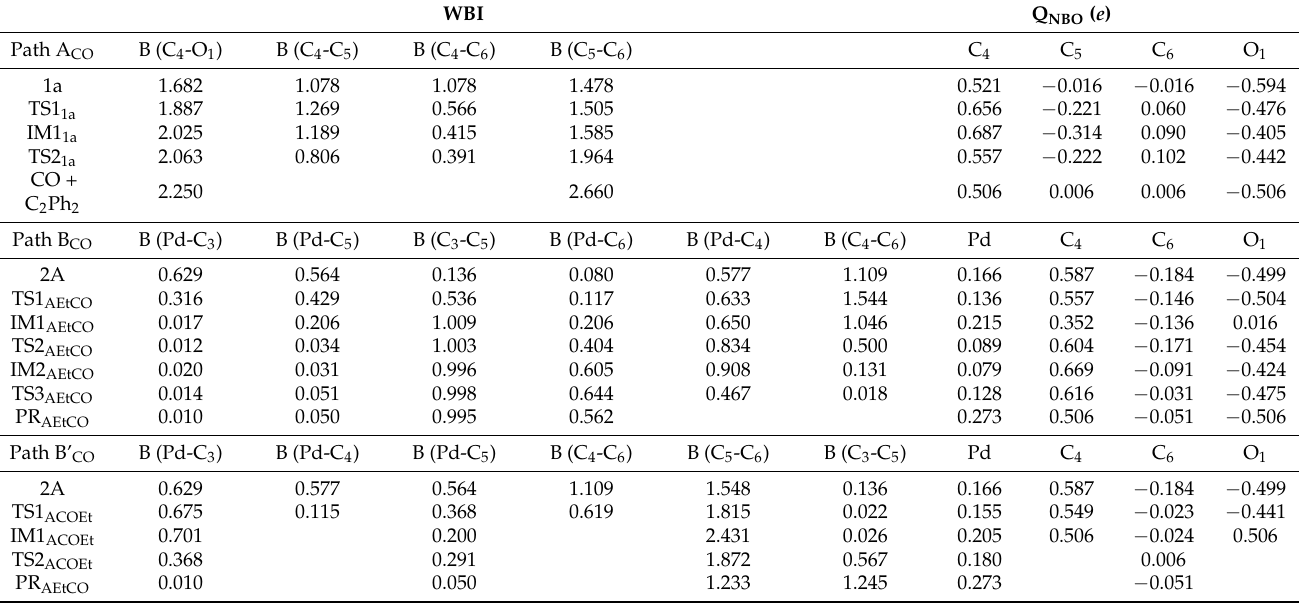
Table 3. The Wiberg bond indices (WBIs) and natural charges (Q NBO ) for some key bonds and atoms of the pathway of generation CO from cyclopropenone. WBI Q NBO ( e